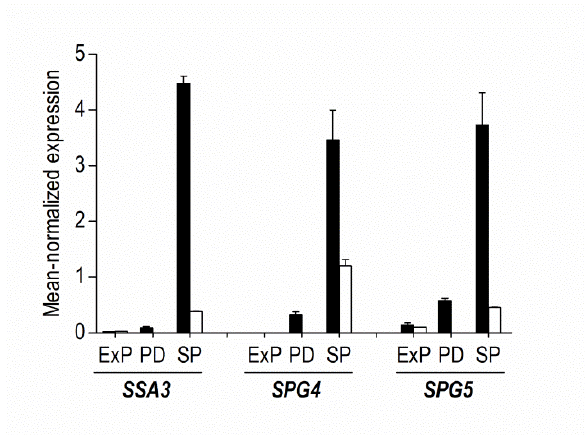
FIGURE 7: Expression levels of the SP-associated genes SSA3 , SPG4 and SPG5 during different growth phases in aerobic and anaerobic batch cultures. The mean-normalized expression values during exponential growth on glucose phase ( ExP ), post- diauxic growth phase ( PD , only aerobic cultures) and stationary phase ( SP , i.e. 4 hours after exhaustion of exogenous consumable carbon-sources) in aerobic ( black bars ) and anaerobic ( white bars ) cultures of S. cerevisiae of the genes SSA3, SPG4 and SPG5 . Average values of duplicate cultures are shown (±